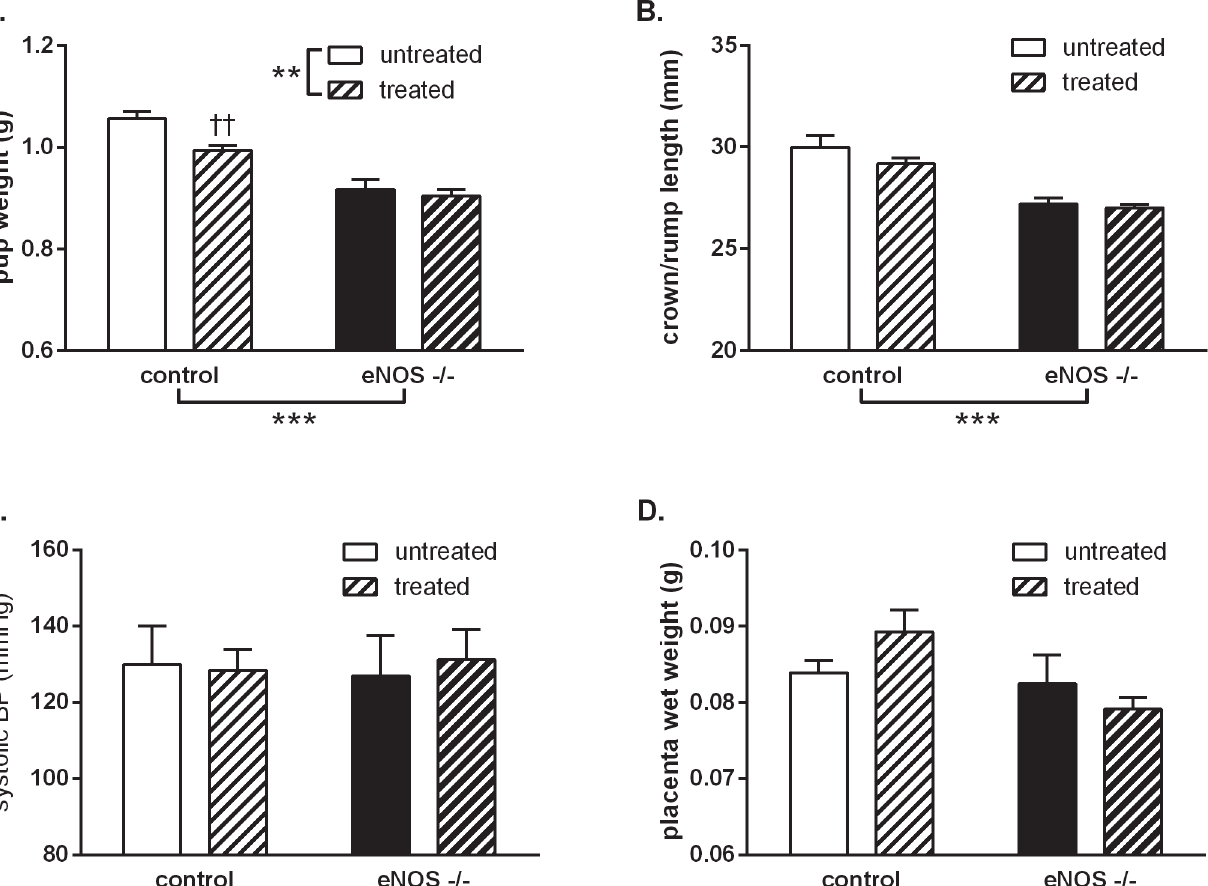
Fig 6. Effect of STS treatment on pregnancy outcomes in mice. Pregnancy outcomes in control (white bars) and eNOS -/- (black bars) late pregnant (GD 18) mice, untreated (open bars) or treated (hatched bars) with STS from GD 12 to 18. STS was given in drinking water at a concentration of approx. 27 mg/kg/ day. A: pup weight, B: pup crown to rump length, C: maternal systolic blood pressure and D: placental weight. Data analysed by two-way ANOVA with a Bonferroni post-test; ** : p < 0.01, *** : p < 0.001, group genotype or treatment effects; †† : p < 0.01 vs. control untreated. Control untreated n = 5(33); control treated n = 8(60); eNOS -/- untreated n = 6(30); eNOS -/- treated n = 7(43); where n =